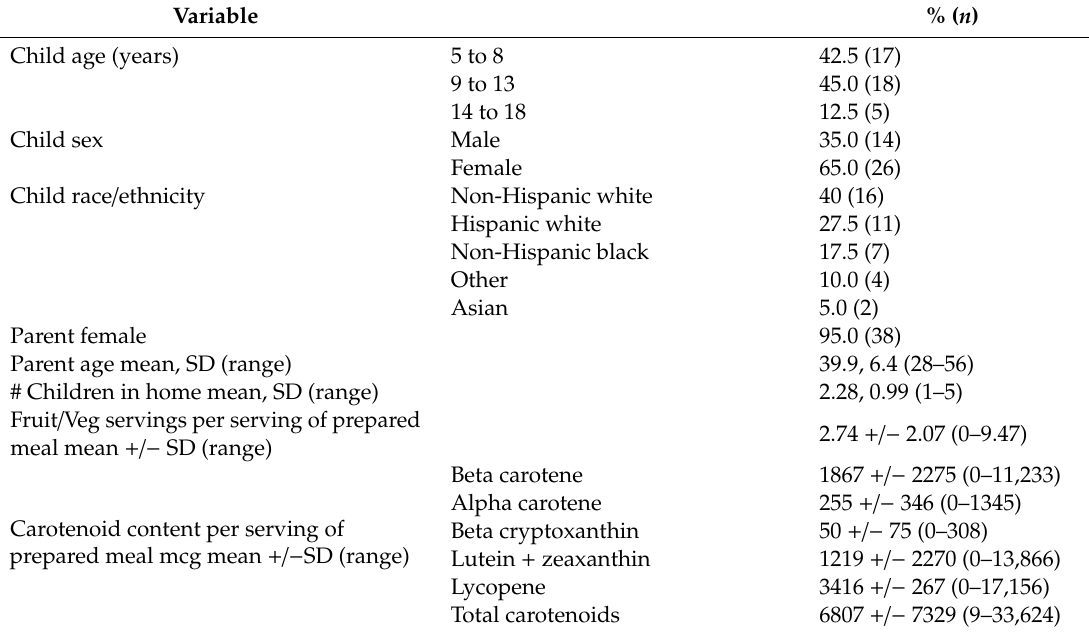
Table 1. Participant demographic and meal carotenoid characteristics.